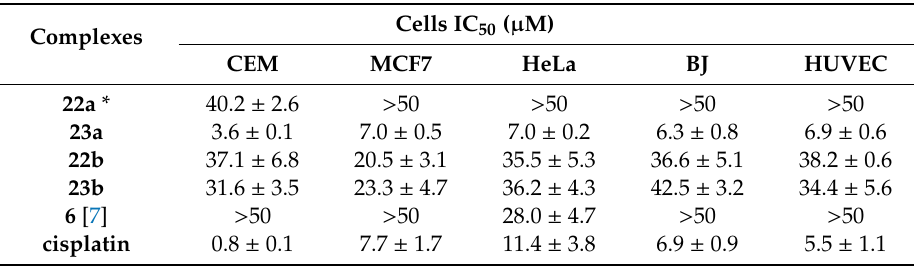
Table 2. IC 50 ( µ M, in DMF) values ± S.D. for the Pt(II)-complexes after 72 h of treatment. Cells IC 50 ( µ Complexes